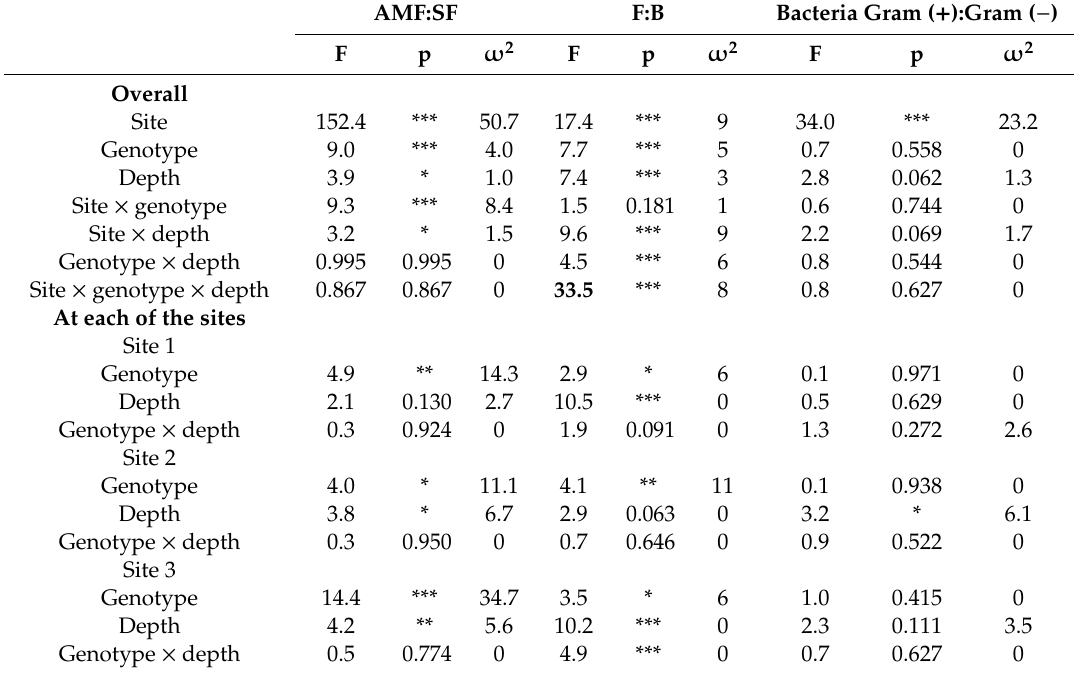
Table 3. Results of ANOVA testing the influence of site, poplar genotype and soil depth on biomass ratio values between both fungal groups (arbuscular fungi (AMF) and soil fungi (SF)), fungal and bacterial biomass ratio (F:B), gram-positive and gram-negative bacteria biomass ratio, and the e ff ect size ( ω 2 ) value of these factors. The following symbols are used to indicate level of significance: * p ≤ 0.05; ** p ≤ 0.01 and *** p ≤ 0.001.